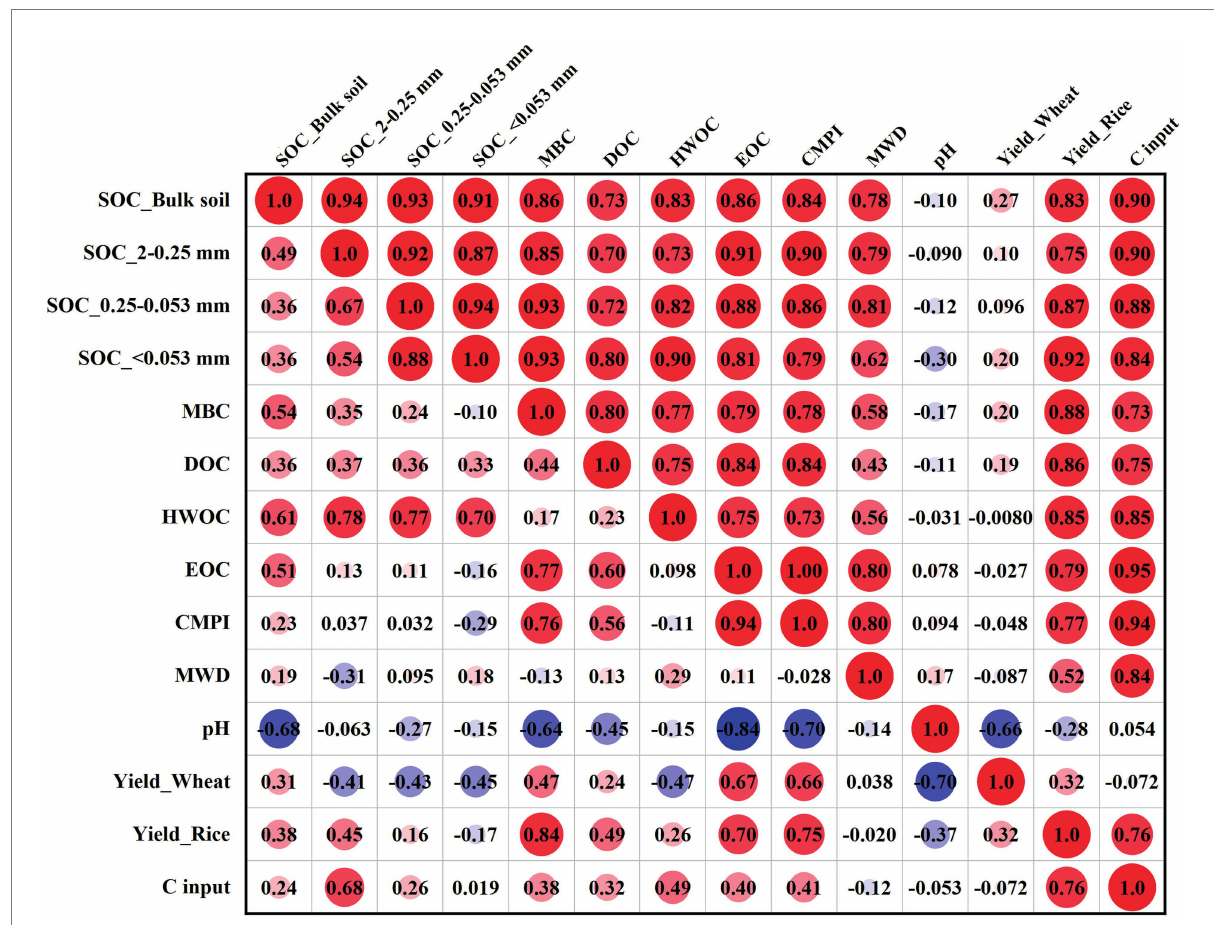
FIGURE 7 Correlation analysis between the SYI of wheat and rice and soil parameters at depths of 0–10 cm (upper triangular matrix) and 10–20 cm (lower triangular matrix). MBC: microbial biomass carbon; DOC: dissolved organic C; HWOC: hot water organic C; EOC: easily oxidized C; CMPI: C pool management index; MWD: mean weight diameter. SYI: sustainable yield